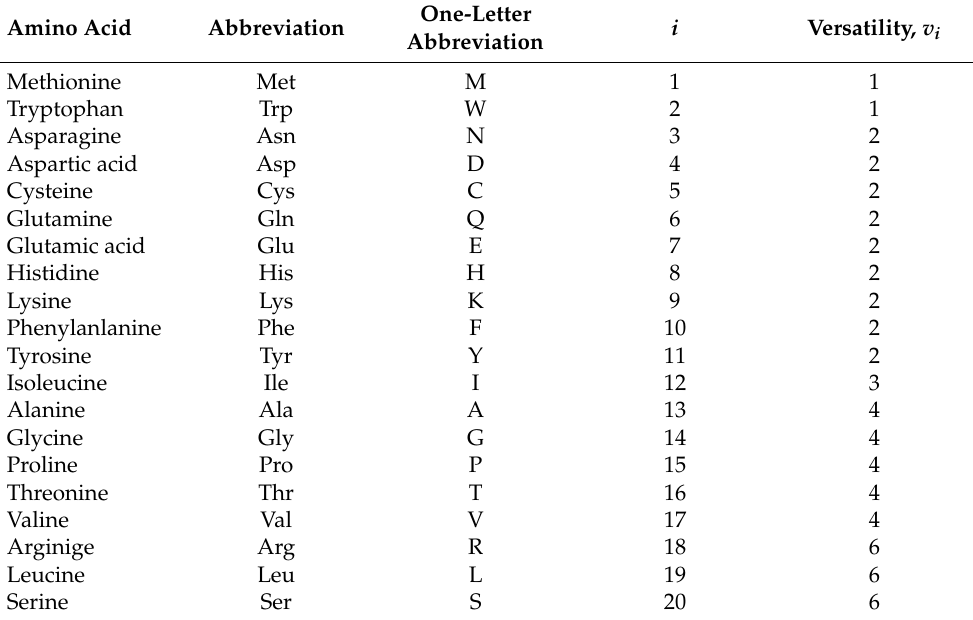
Table 4. List of the 20 most frequent amino acids with their abbreviations. They are ordered according to their versatility (number of different codons for each amino acid) and alphabetically within each versatility value. Three stop codons are not considered, since they correspond to nonsense mutations causing truncated proteins that have been removed from the